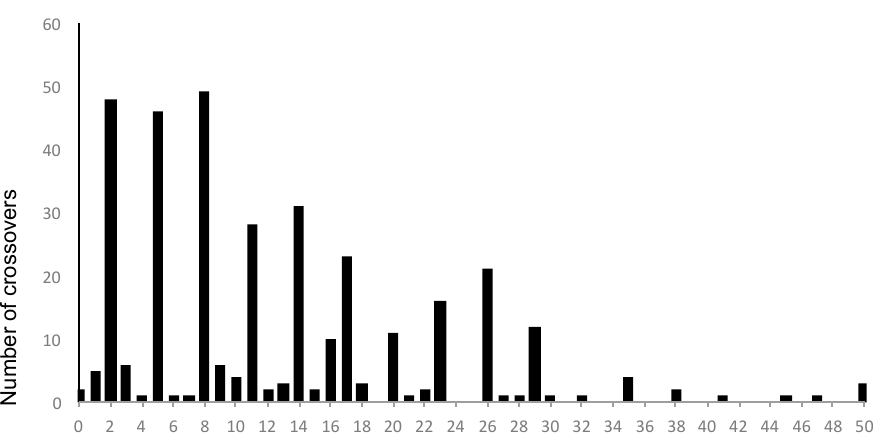
Figure 6. The dependence of the frequency of crossovers on the length of homologous sequences in the relevant regions of the recombining partners. Peaks corresponding to homology lengths of 2, 5, 8, etc. are caused by the fact that the most often difference between sequences of 3 serotypes concerns the third positions of the codons.